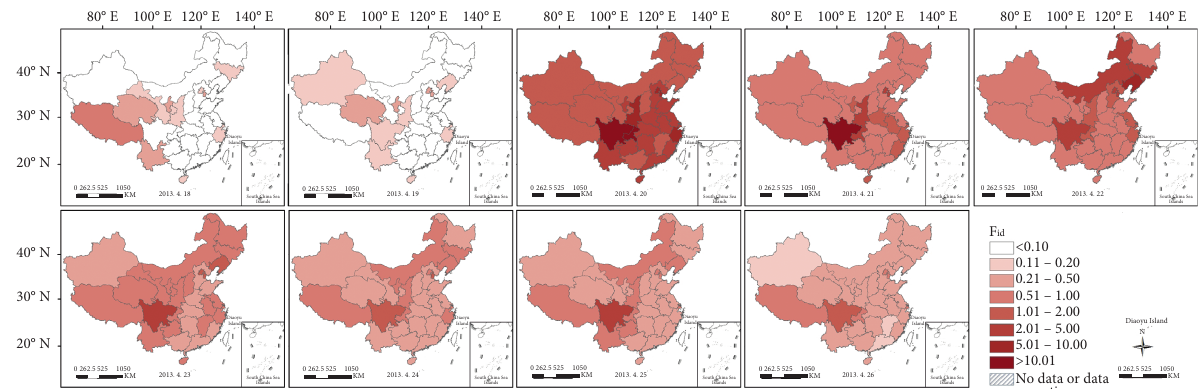
Figure 3: F id before and after the Yaan earthquake (4/18/2013–4/26/2013).